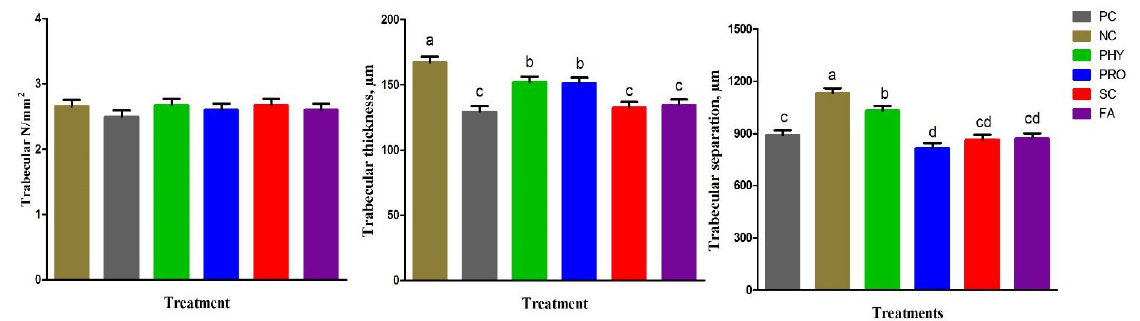
Figure 3. Effect of dietary treatments on trabecular bone properties of tibia in broiler chickens at 35 d of age. Data represented as mean ± SEM. a – c Means with different letters are varied at p ˂ 0.05. For treatment abbreviations, see Table 2.